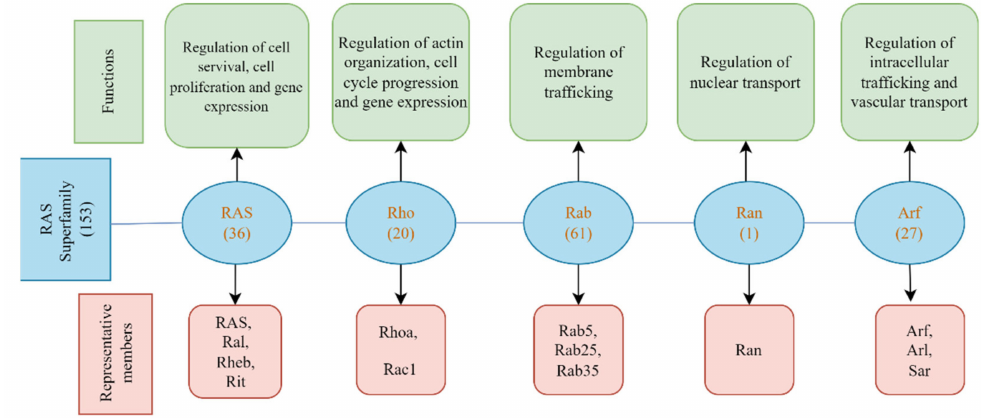
Figure 1. Classification of the RAS superfamily